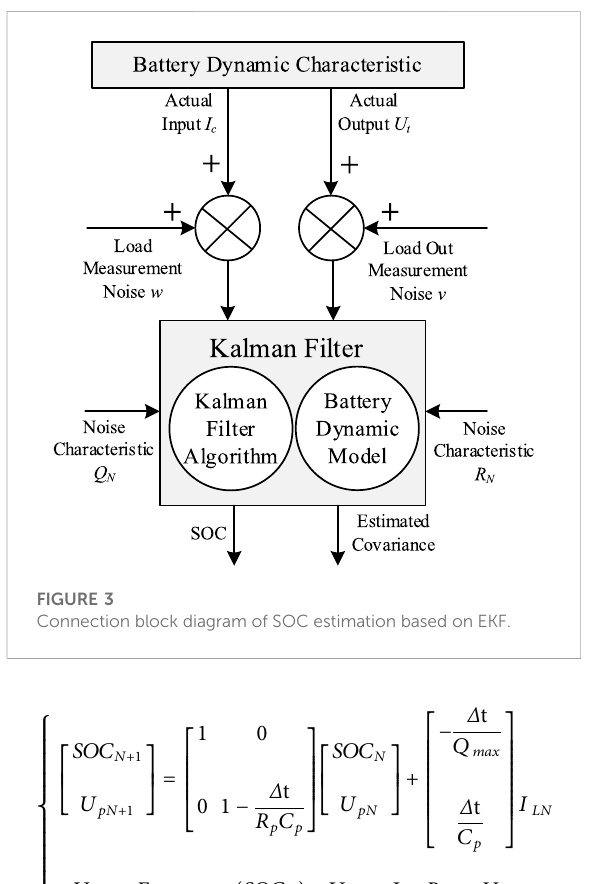
FIGURE 5 SOC estimation curve of EKF method under non-constant current